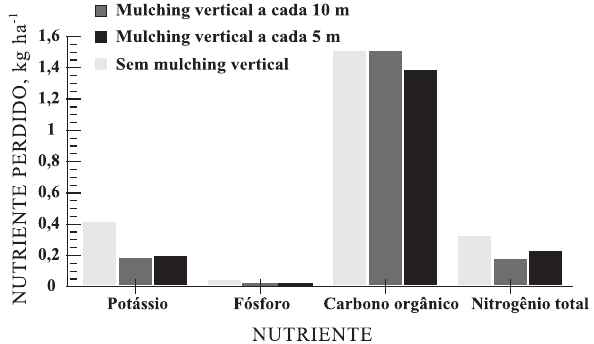
Figura 3. Perda de nutrientes e de carbono orgânico na água do escoamento superficial, obtida com chuva simulada com intensidade de 106 mm h -1 , em Latossolo Vermelho distrófico típico durante o ciclo da cultura do trigo, em semeadura direta, nos tratamentos sem vertical mulching , vertical mulching a cada 10 m e vertical mulching a cada 5